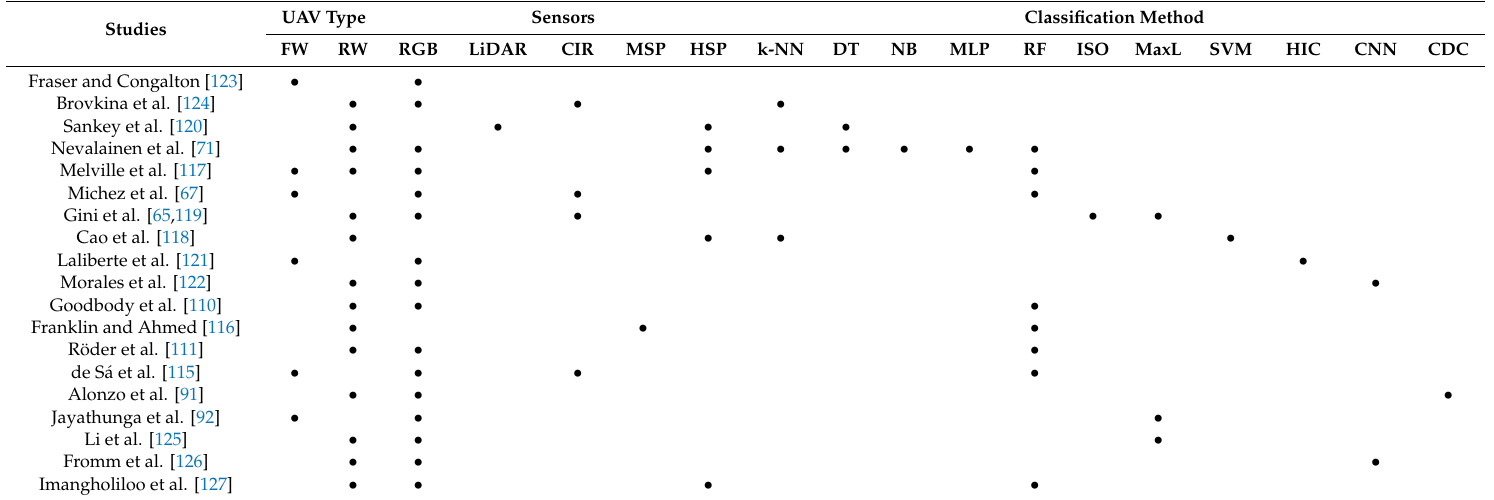
Table 3. Unmanned aerial vehicle type, sensing payloads and classifiers used for tree